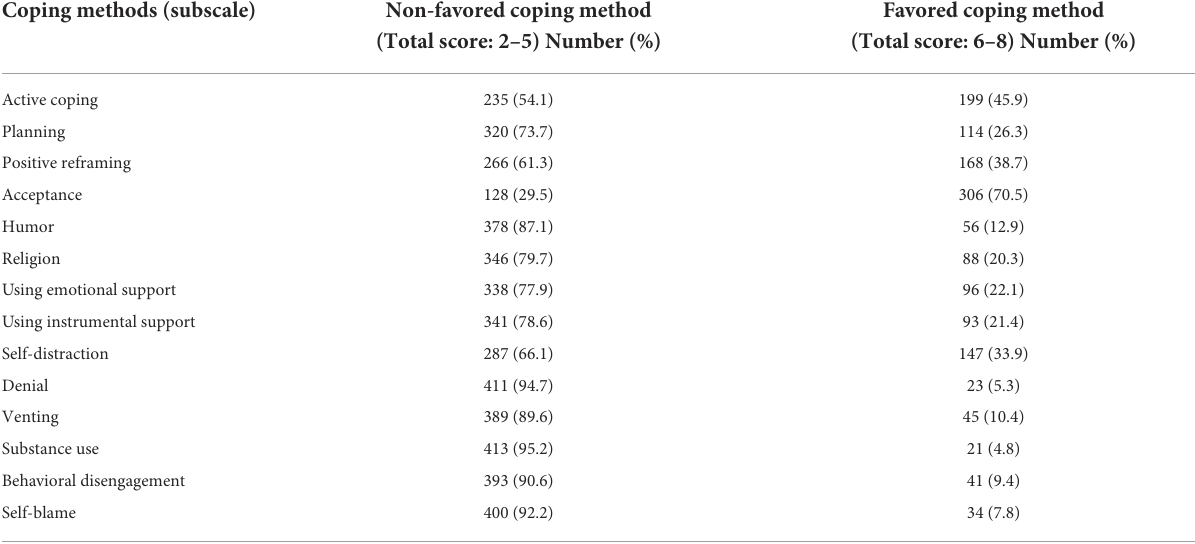
TABLE 3 Number (%) of respondents who frequently used the coping methods listed ( n = 434). Coping methods (subscale)